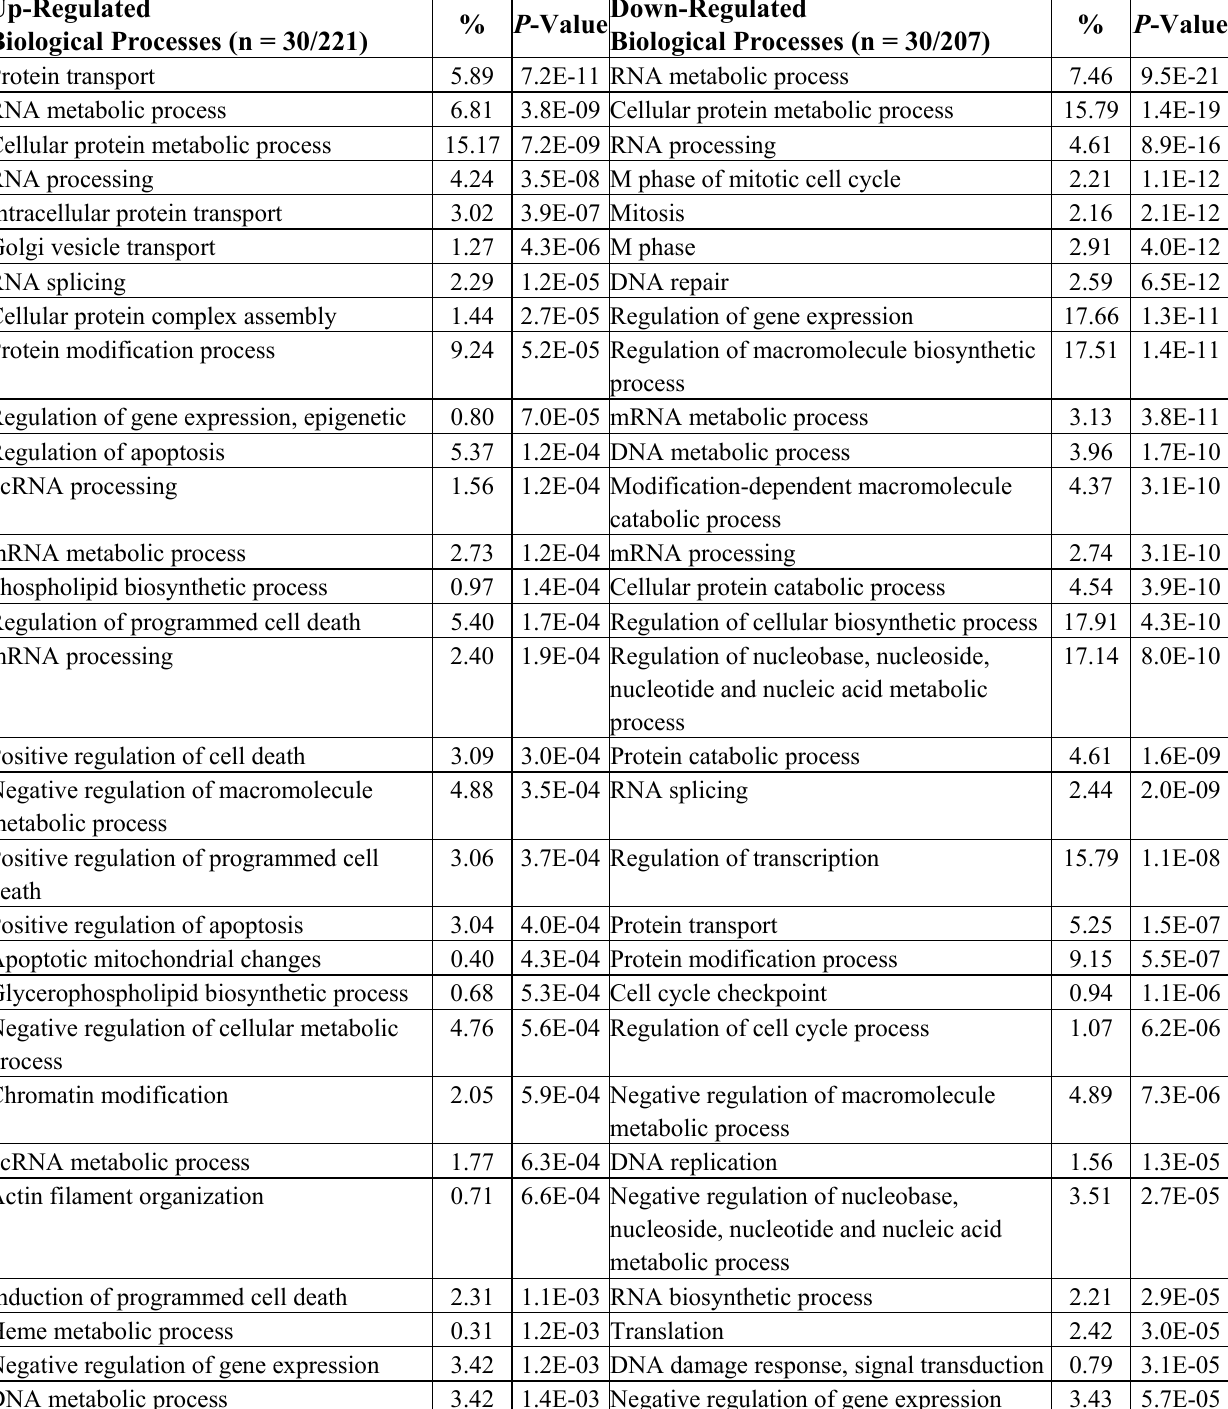
Table 1. Over-represented gene ontology categories deregulated in NCI-H460 cells by PAC treatment.